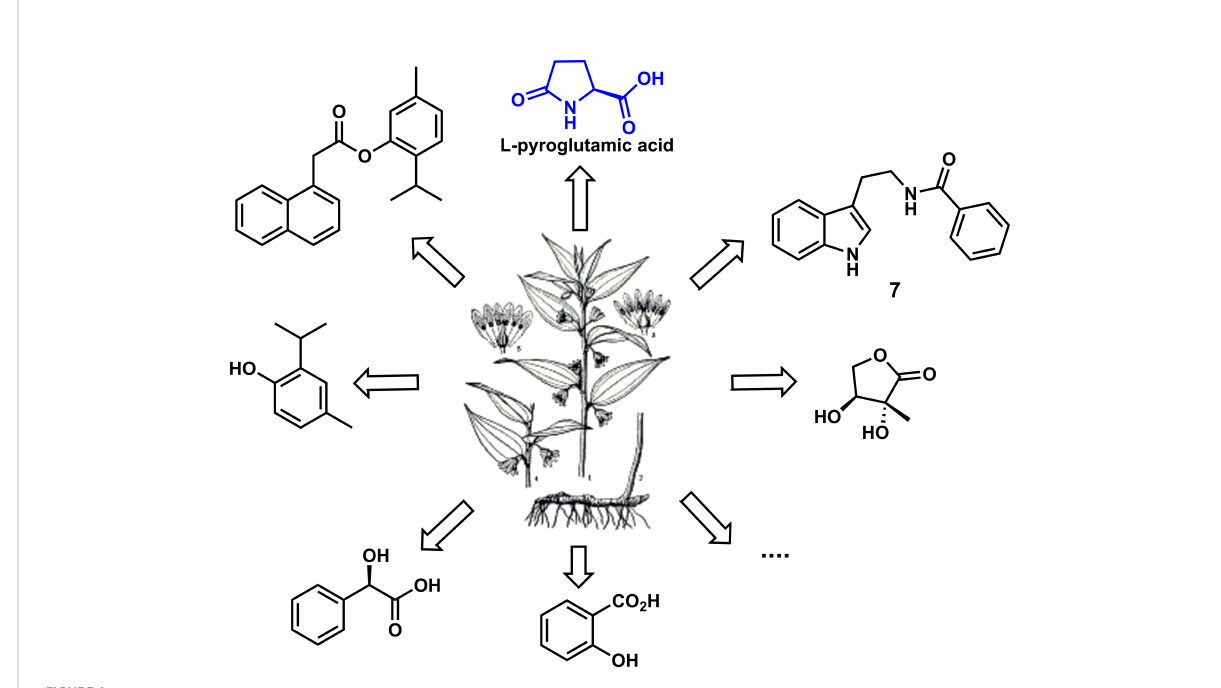
FIGURE 1 Antifungal compounds from Disporopsis aspersa (HUA) ENGL. ex